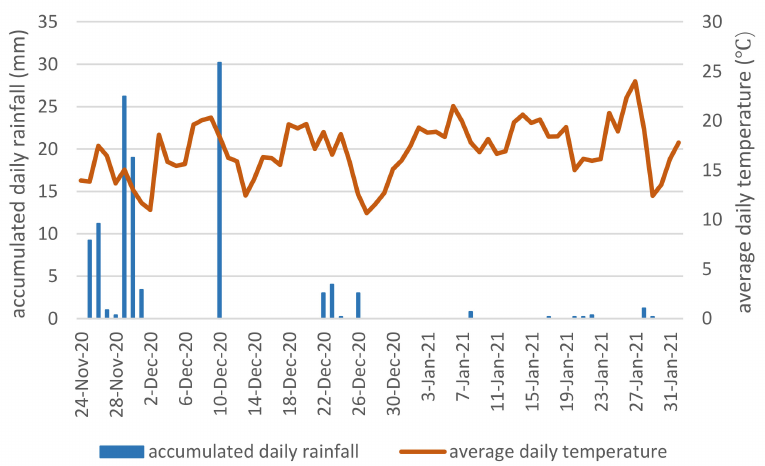
Figure 2. Average daily temperature (red line) and accumulated daily rainfall (blue bars) recorded by the weather station at Palliser Estate between 27 November 2019 and 1 February